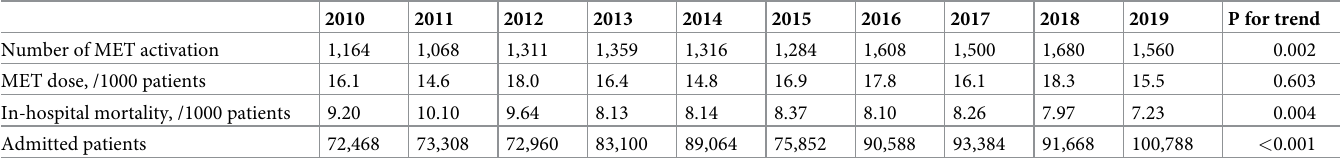
Table 3. Annual trend of the MET activation and in-hospital mortality.